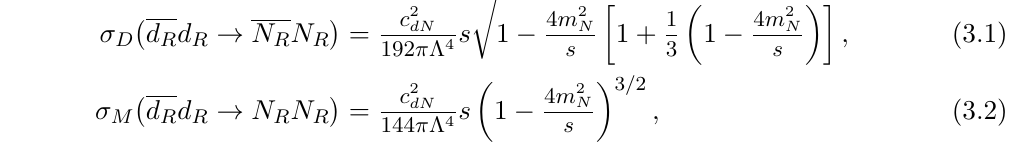
= 1 ( c ij = 0 for ( i, j ) 6 = (1 , 1) ) with √ √ dN dN 2 ). The factor 2 is due